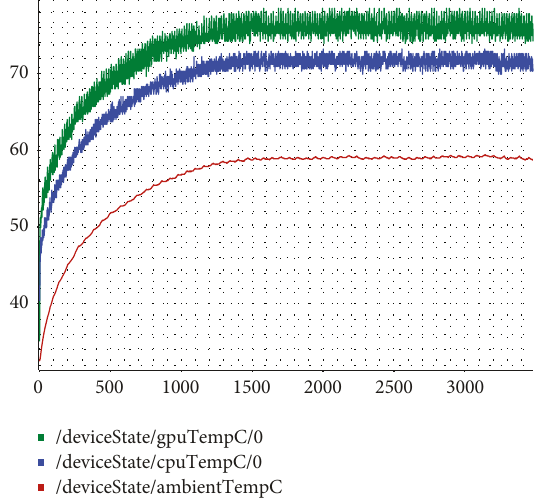
Figure 57: T2N2 left (1) and right (2) lane recognition.